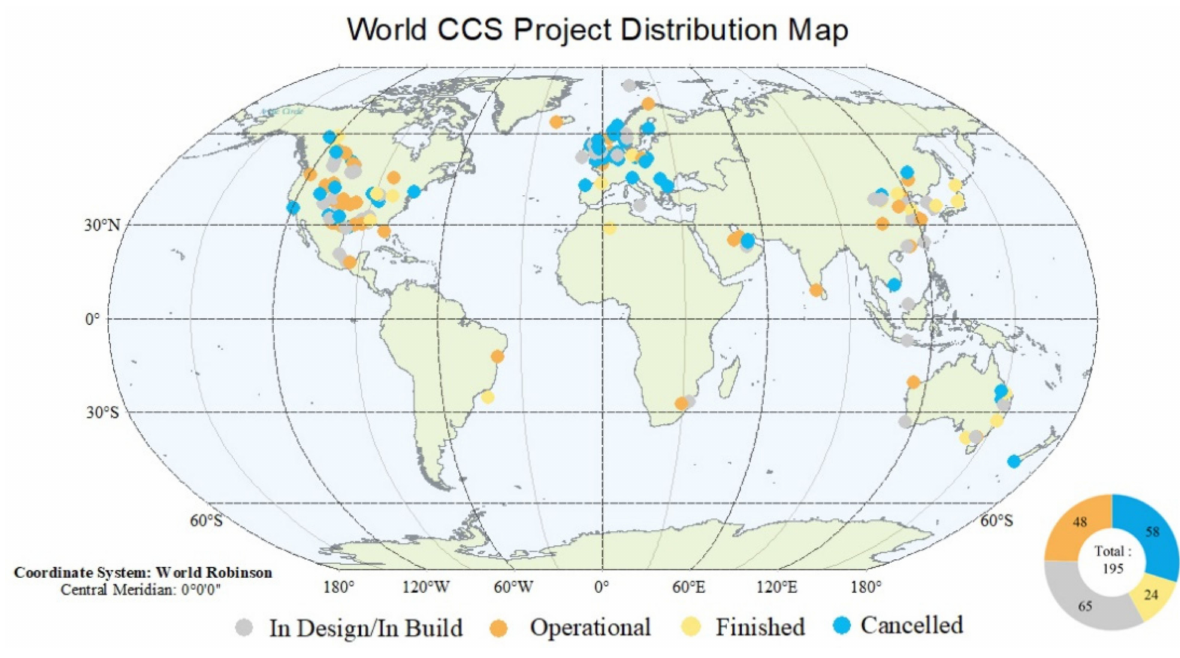
Figure 1. CCS project distribution